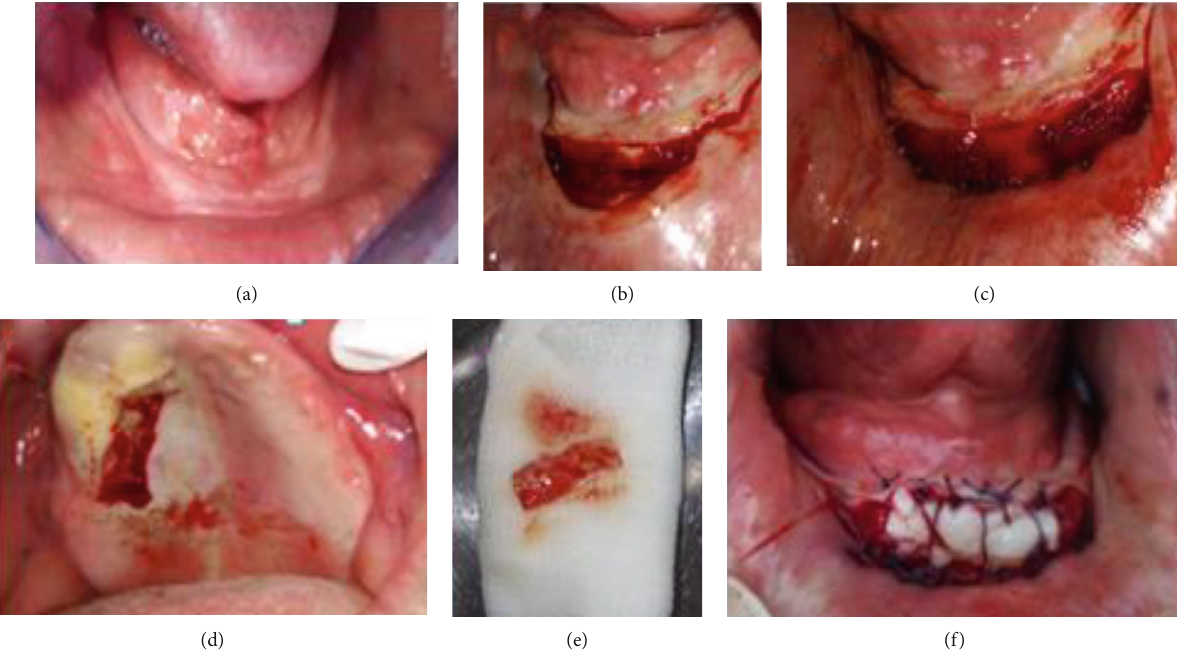
Figure 6: The surgical procedure: (a) preoperative view, (b) horizontal semilunar incision followed by Supra periosteal dissection deepening the vestibule, (c) suturing of the mucosal fl ap, (d, e) epithelioconnective palatal fl ap, and (f) immediate postoperative view.